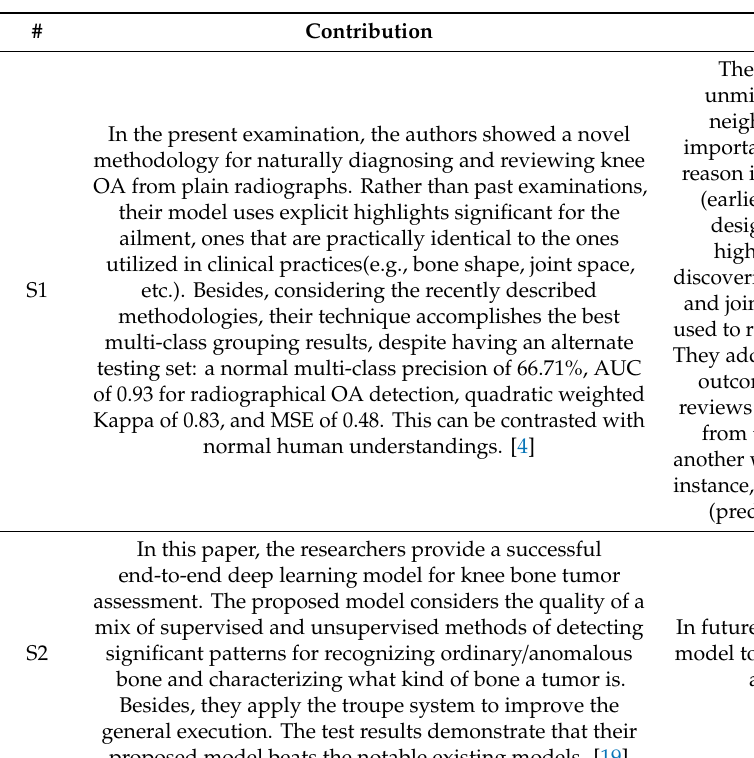
Table 11. Extracted data from papers including contributions, predictions, and advantages of related deep learning